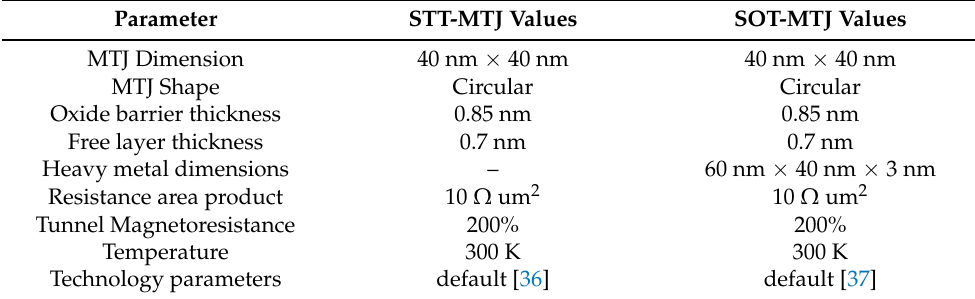
Table 1. MTJ Parameters used for electrical simulations. Parameter STT-MTJ Values Circular Circular Oxide barrier